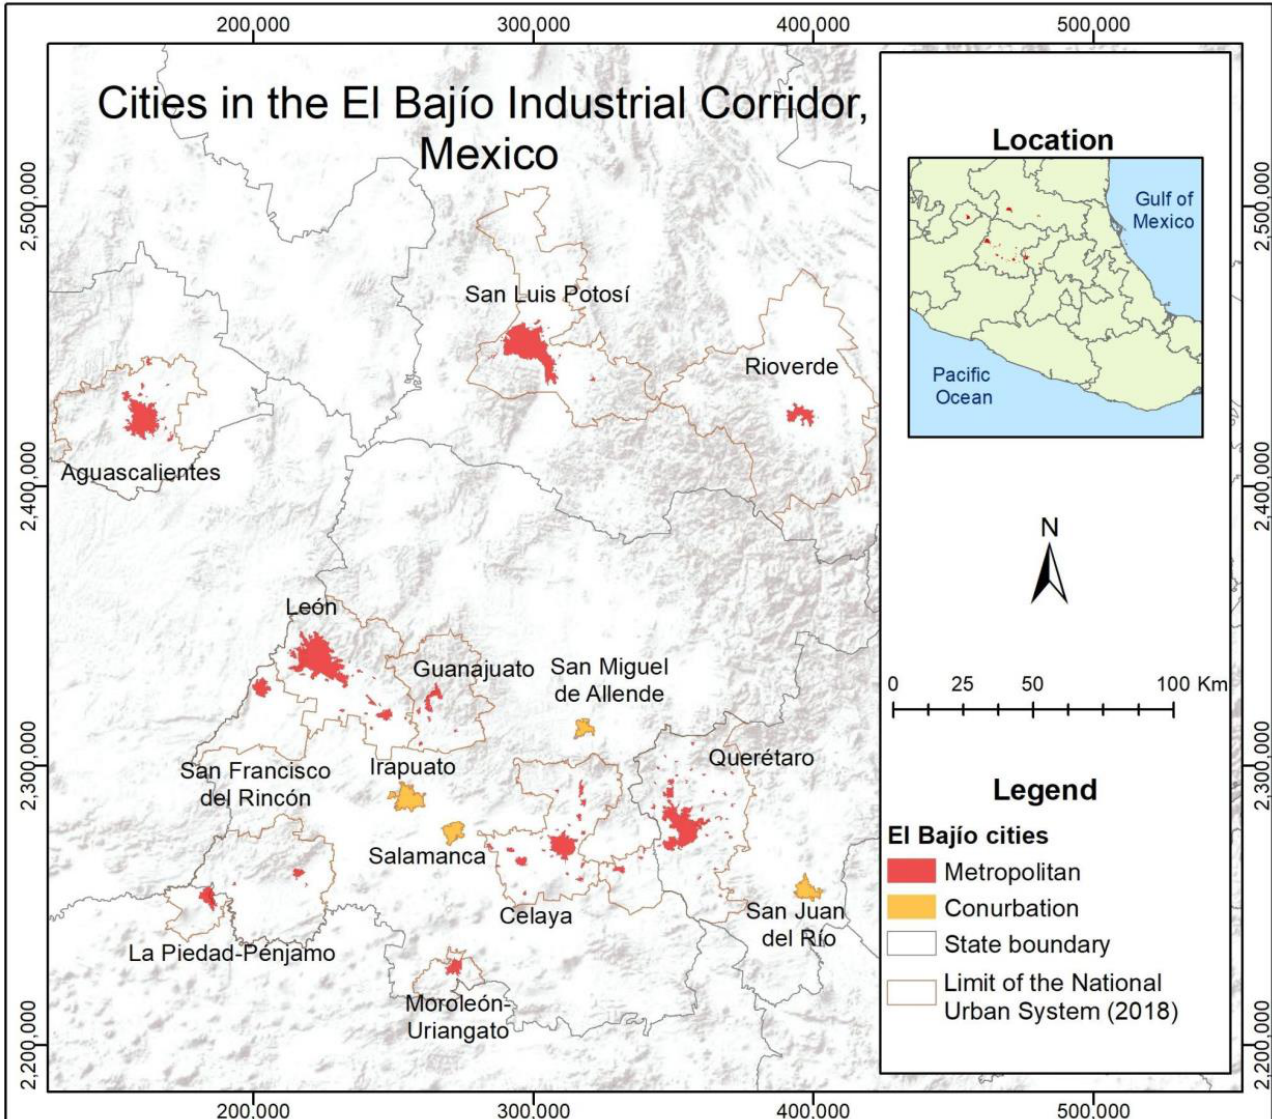
Figure 1. Metropolitan and conurbations cities of the El Bajío Industrial Corridor, Mexico.